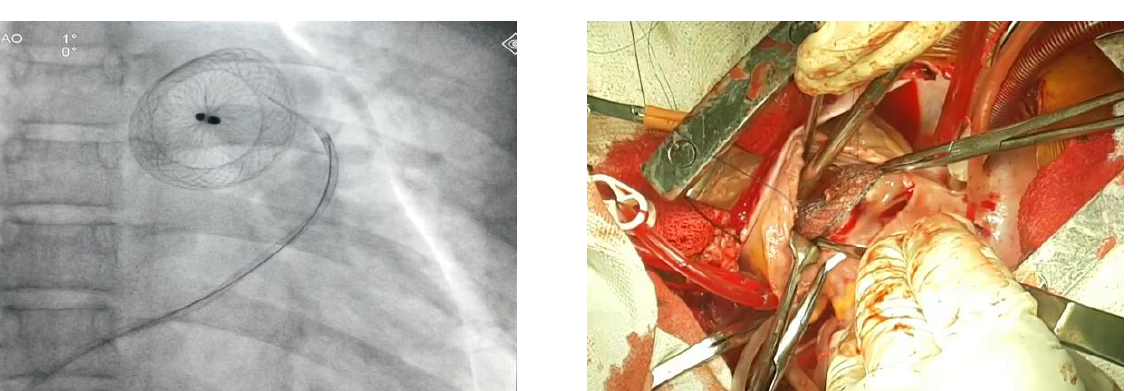
Figure 1 . Embolization of Amplatzer atrial septum defect occluder device into the main pulmonary artery